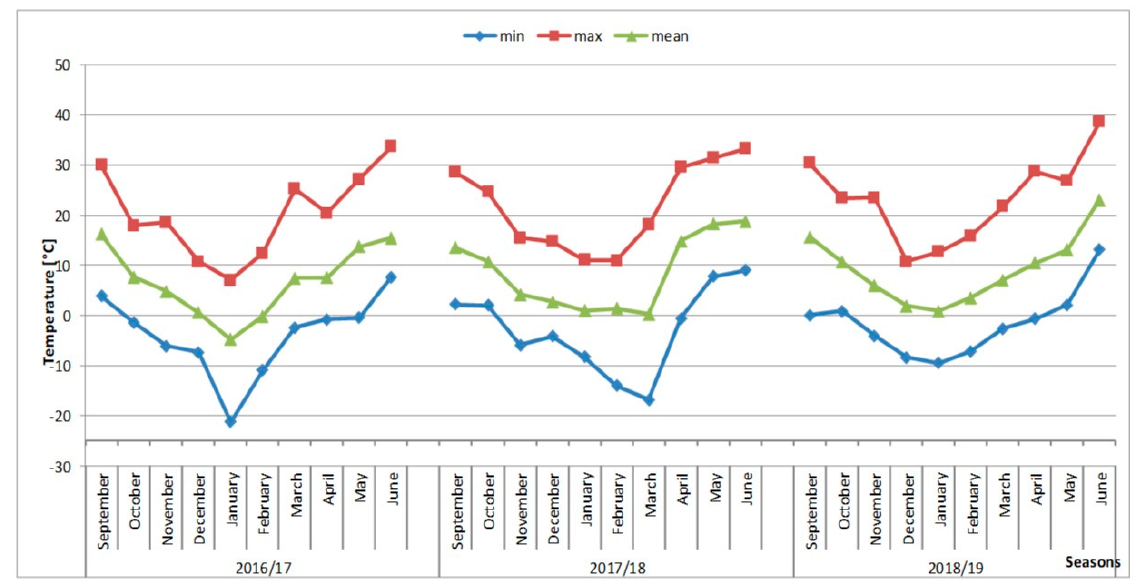
Figure 5. Daytime temperatures during the growing season of R. illyricus (September–June) in the years 2015–2019. Table 4. Correlation matrix of mean temperatures and size of tuber cluster (its FM and number of tubers).